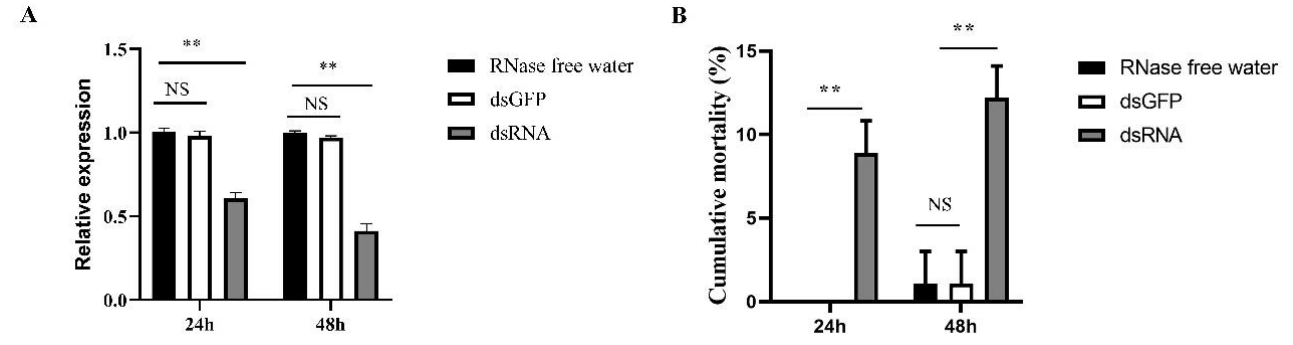
Figure 10. Silencing of LoTRE1 using RNAi. ( A ) The relative expression levels of the LoTRE1 gene after silencing for 24 and 48 h. ( B ) The mortality rates of adults after feeding on different treated leaves for 24 and 48 h. All data obtained were expressed as the means ± standard deviations of three replicates and were tested using a one-way ANOVA and t tests using SPSS 22.0. No significant differences are indicated by NS. The significant differences are indicated by ** ( p < 0.01).